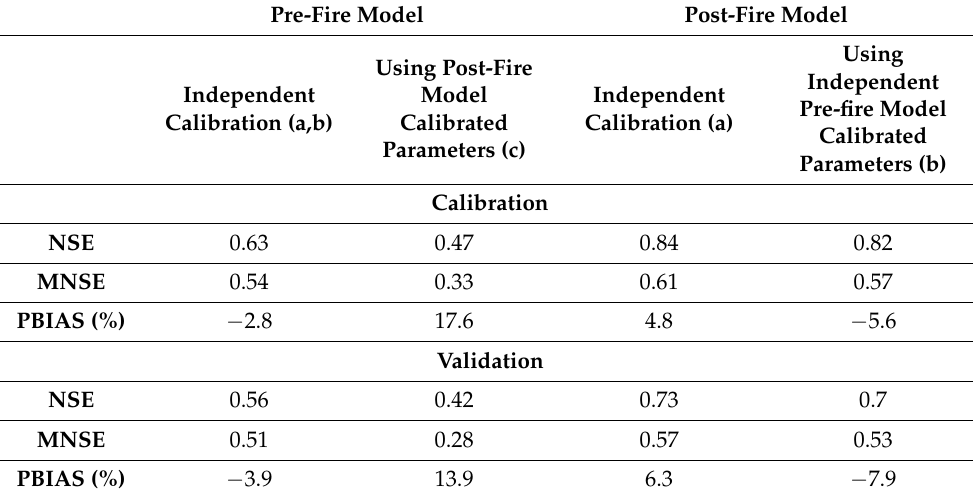
Table 2. Model performance metrics for the three calibration approaches, ( a ) independent calibration of both configurations, ( b ) independent calibration of the pre-fire model and calibration of only the parameters affected by the forest fire for the affected parts of the watershed (using pre-fire model calibrated parameters), ( c ) independent calibration of the post-fire model and use of the common parameters for the pre-fire model (using post-fire model calibrated parameters). NSE is the Nash–Sutcliffe efficiency MNSE is the modified Nash–Sutcliffe efficiency and PBIAS is the percent bias. Pre-Fire Model Post-Fire Model Using Using Post-Fire Independent Model Independent Independent Pre-fire Model Calibrated Calibration (a) Calibration (a,b) Calibrated Parameters (c) Parameters